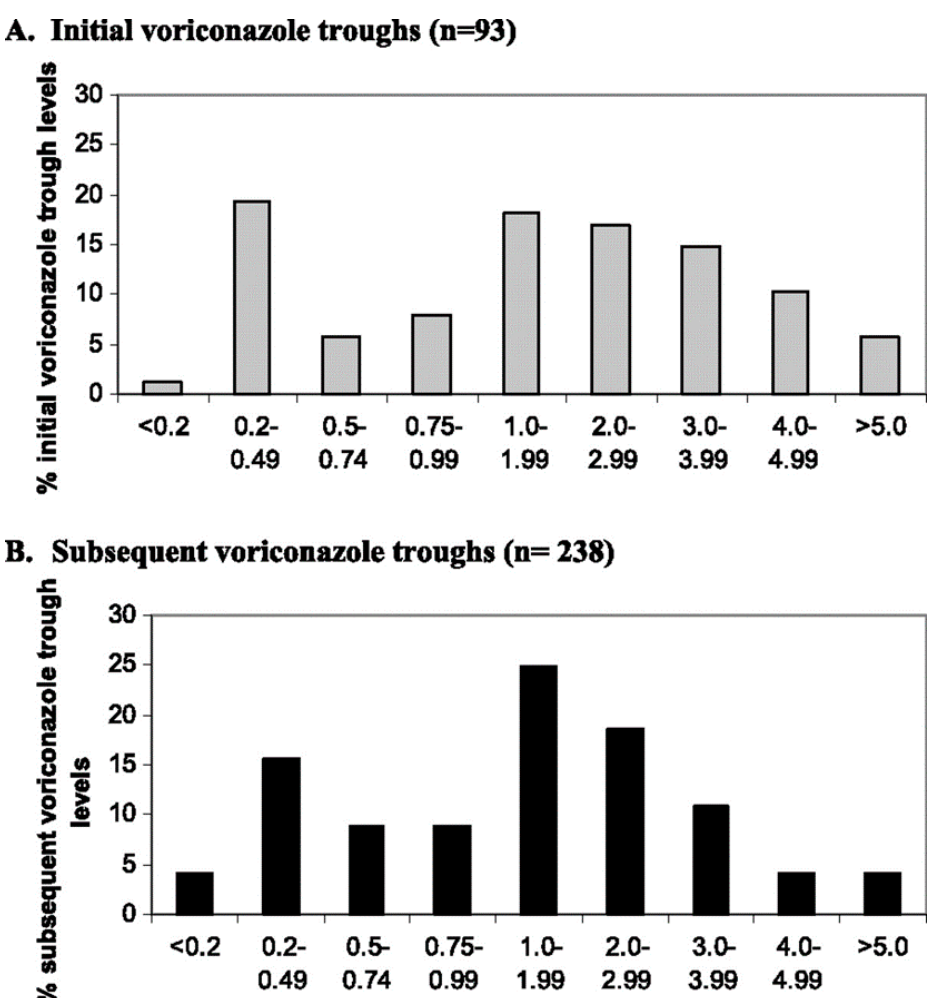
Figure 1. Distribution of voriconazole troughs after initial and subsequent doses in a sample of lung transplant recipients [3]. X-axis displays range of recorded voriconazole trough values in µg/mL. Y-axis describes percentage of patients within the respective voriconazole trough ranges. Reproduced with permission from American Society for Microbiology.